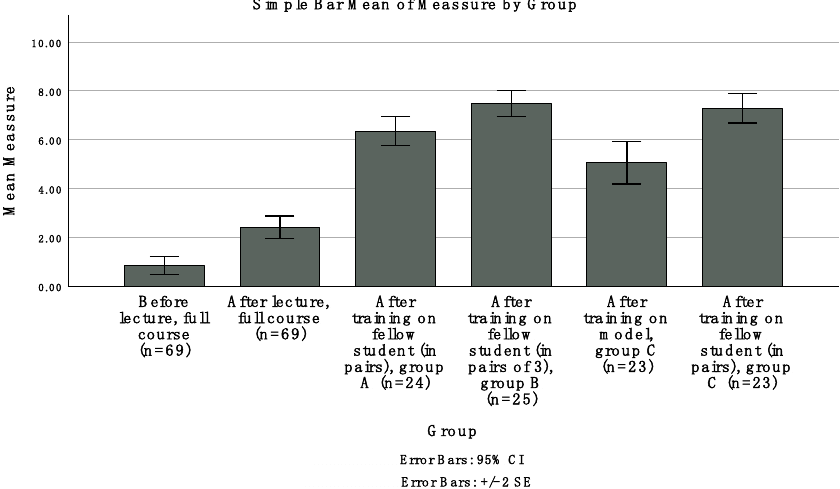
Figure 3. Students’ self-evaluation about self-confidence in independently administering anesthesia to patients before the theoretical lecture, after the theoretical lecture, after training on a model and after training on a fellow student. Each question was answered based on self-assessment on a 10-point graded scale (0 = absolutely not confident in independently administering anesthesia to patients, 10 = completely confident in independently administering anesthesia to patients).